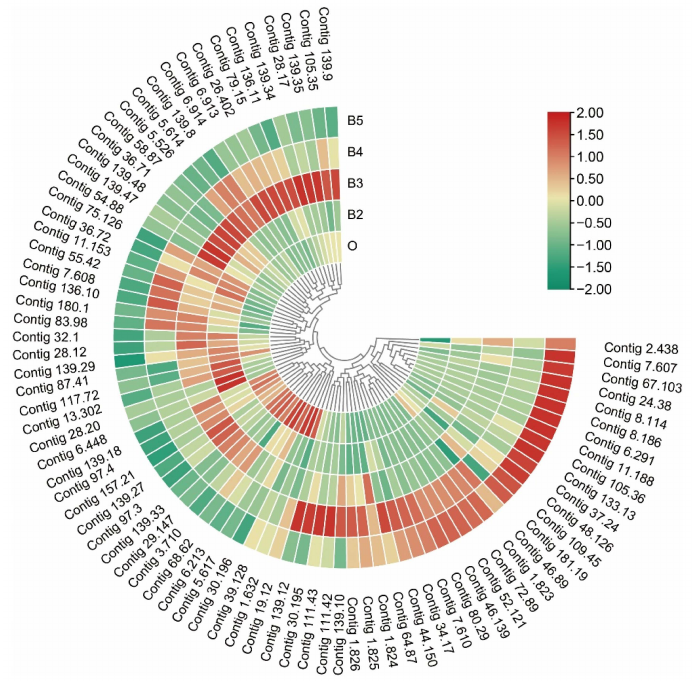
Figure 9. Expression profiles of genes in chitin-related pathway. The color scale on the right shows the FPKM values for each developmental stage from red (high) to green (low), standardized by min–max normalization. Insects 2022 , 13 , x FOR PEER REVIEW